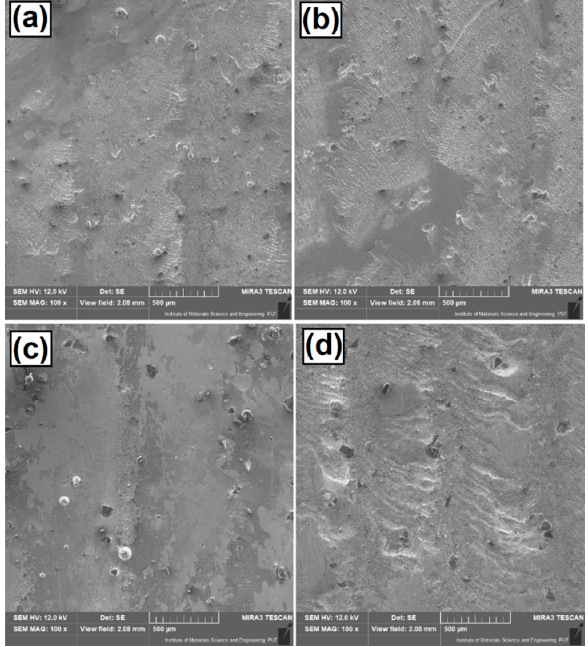
Figure 12. Surface conditions before wear resistance test: ( a ) Fe–B coating (#1 laser beam parameters);